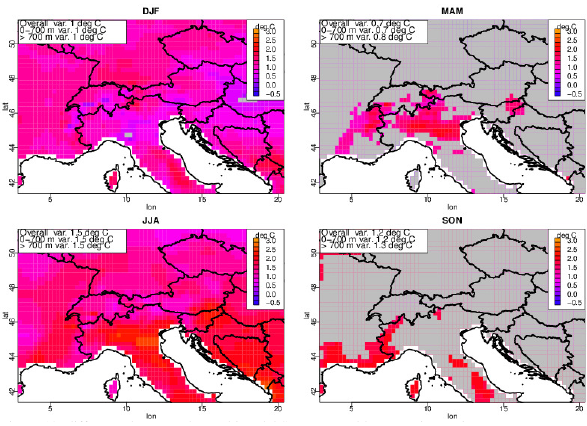
Figure 12: difference between the Multimodel SuperEnsemble scenario maximum temperatures averaged over the period 2031-2050 with respect to the period 1981-2000, as a function of the season (T-test conf. level 95%) in the GAR area. Fig. 12. Difference between the multimodel superensemble sce- nario maximum temperatures averaged over the period 2031–2050 with respect to the period 1981–2000, as a function of the season ( T test conf. level 95%) in the GAR area.